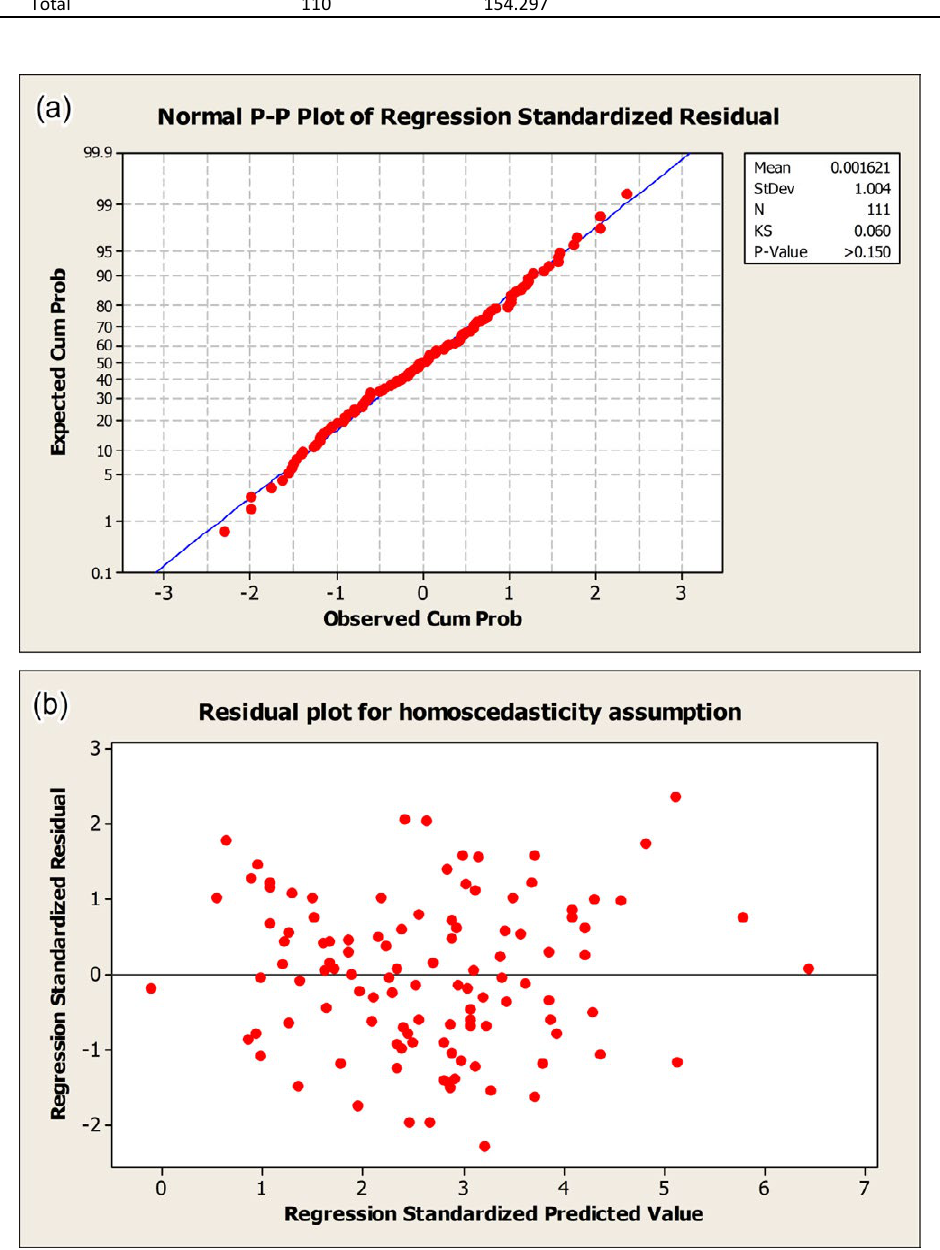
Fig. 4: Verification of model assumptions: (a) Normality of residuals, (b) Independence of residuals